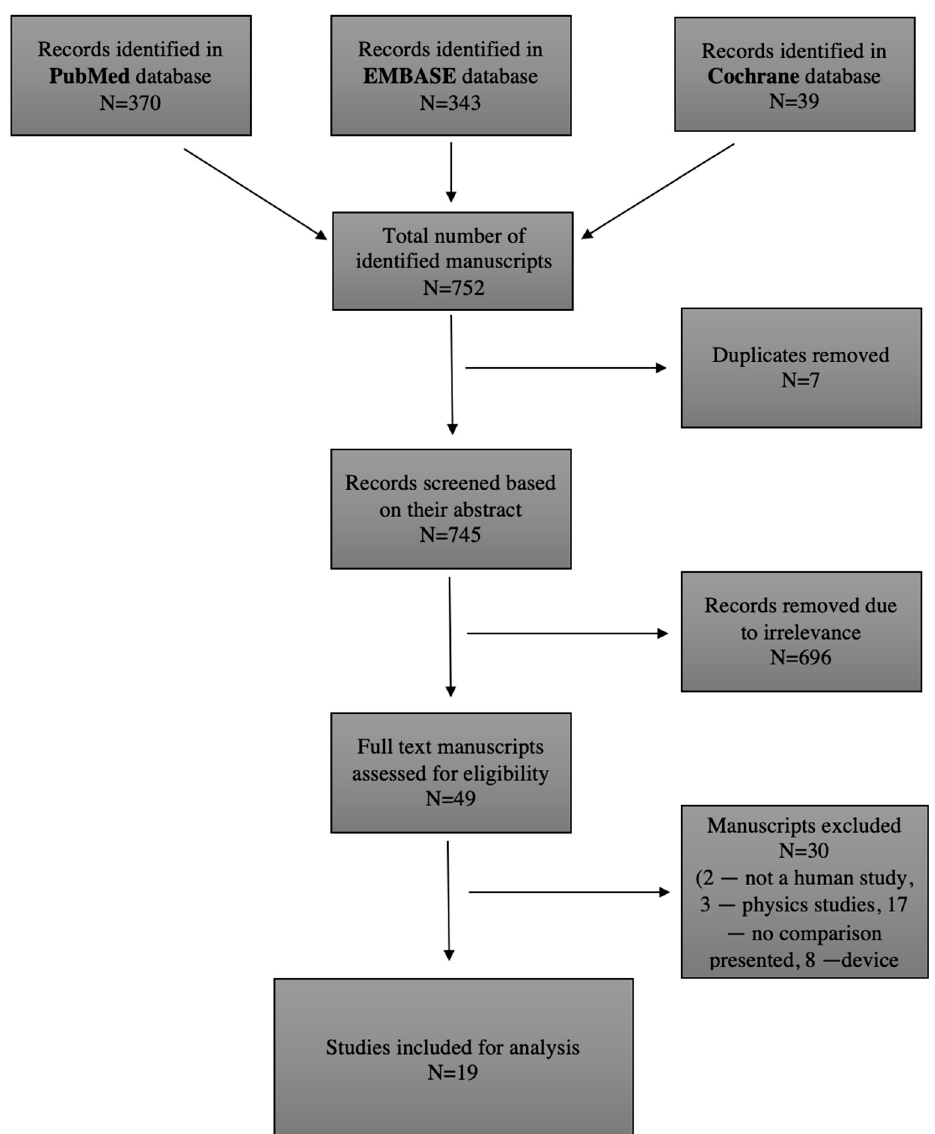
Figure 1. Literature search strategy and outcomes.